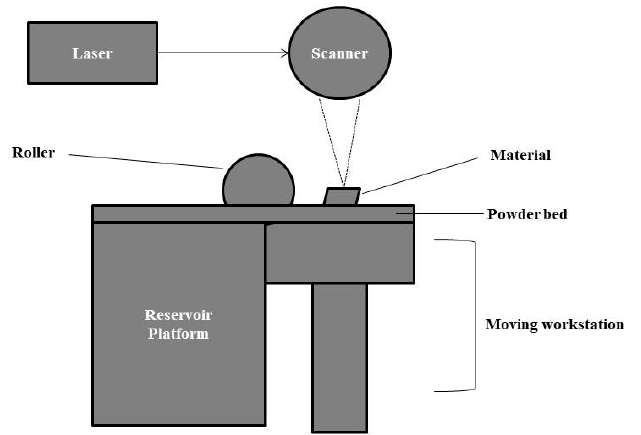
Figure 12 . Simplified diagram of selective laser sintering, which consists of a reservoir platform, moving workstation, roller, and a scanner . moving workstation, roller, and a